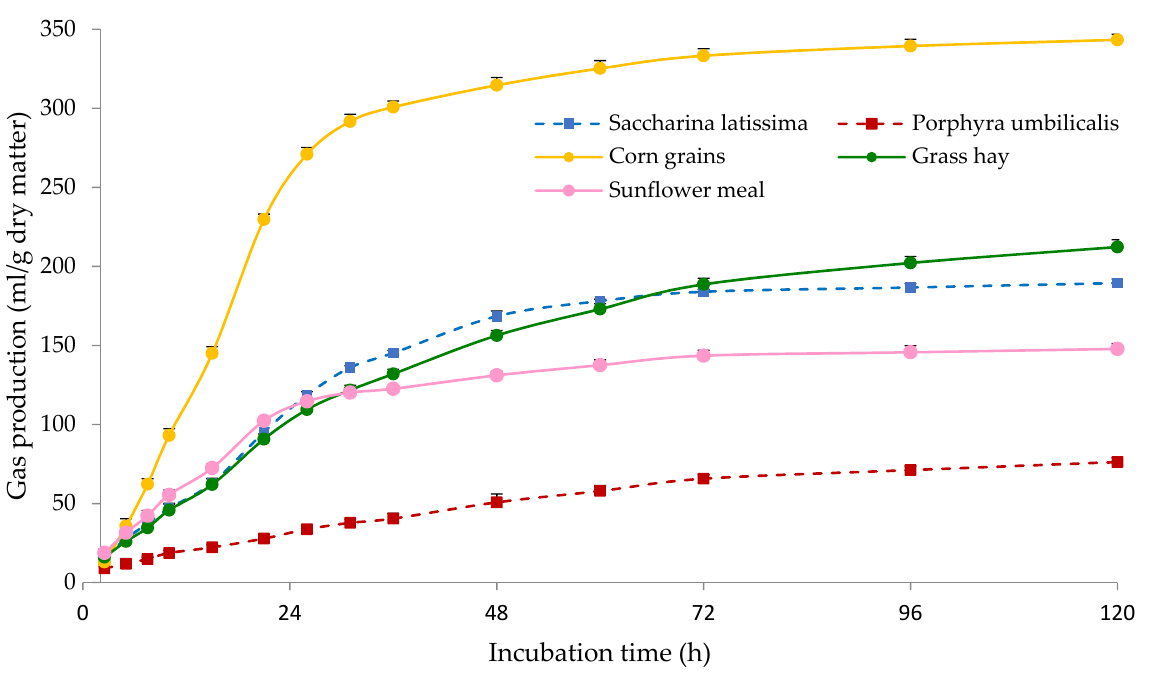
Figure 2. Gas production kinetics of Saccharina latissima , Porphyra umbilicalis , grass hay, corn grains and sunflower meal. The bars indicate the standard error of the mean (n = 4).